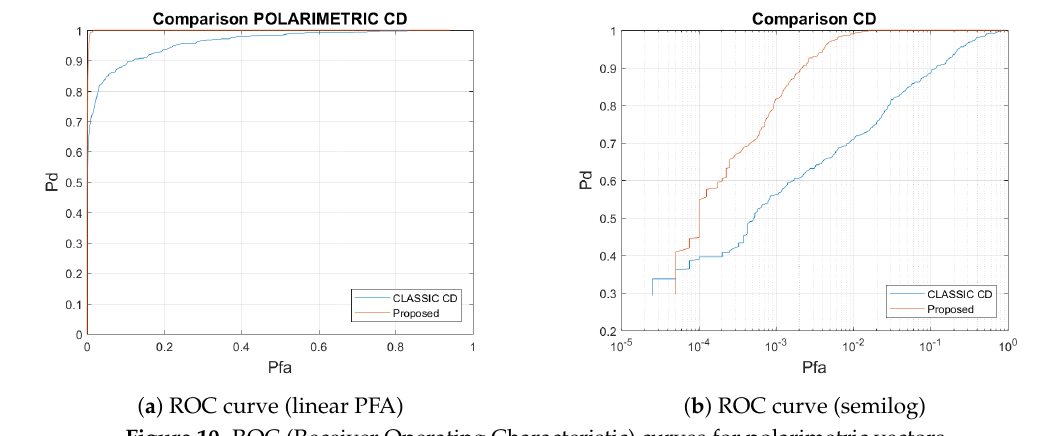
Figure 10. ROC (Receiver Operating Characteristic) curves for polarimetric